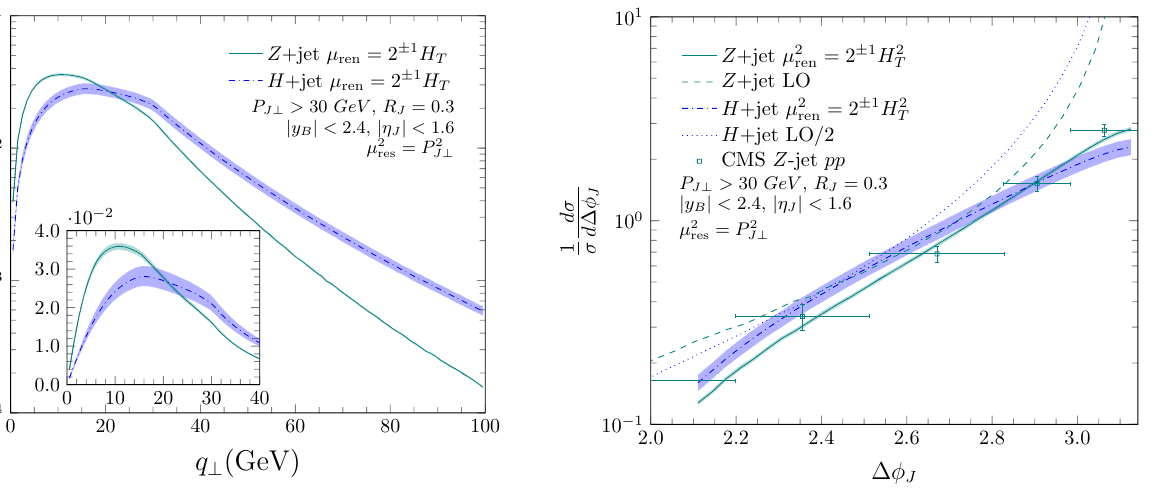
Fig. 4 Normalized q ⊥ distribution for both Z + jet (solid) and H + jet (dashdotted) processes at 5.02 TeV. The resummation scale is fixed at μ 2 = P 2 , while the renormalization scale varies by a factor μ 2 ren = res J ⊥ 2 ± 1 H 2 T